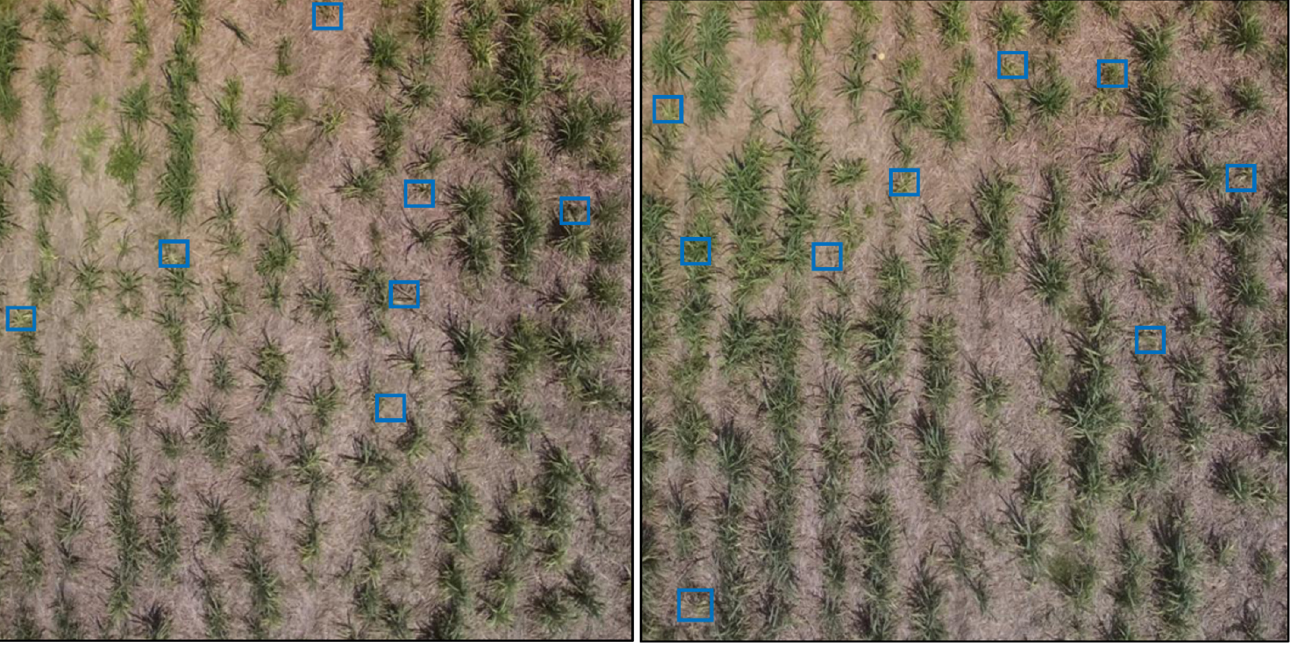
Figure 17. Bounding box detection using DETR.